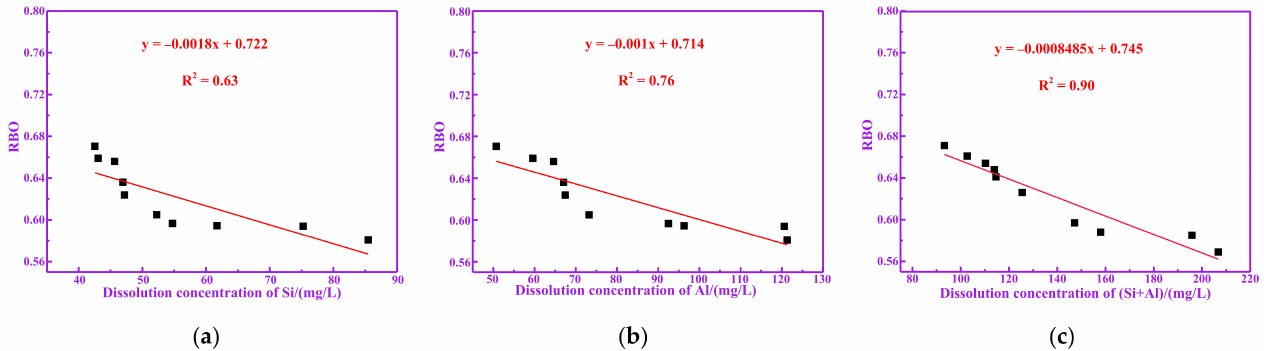
Figure 8. Correlation between dissolution concentration of (Si+Al) and RBO. ( a ) Si; ( b ) Al; ( c ) (Si+Al).